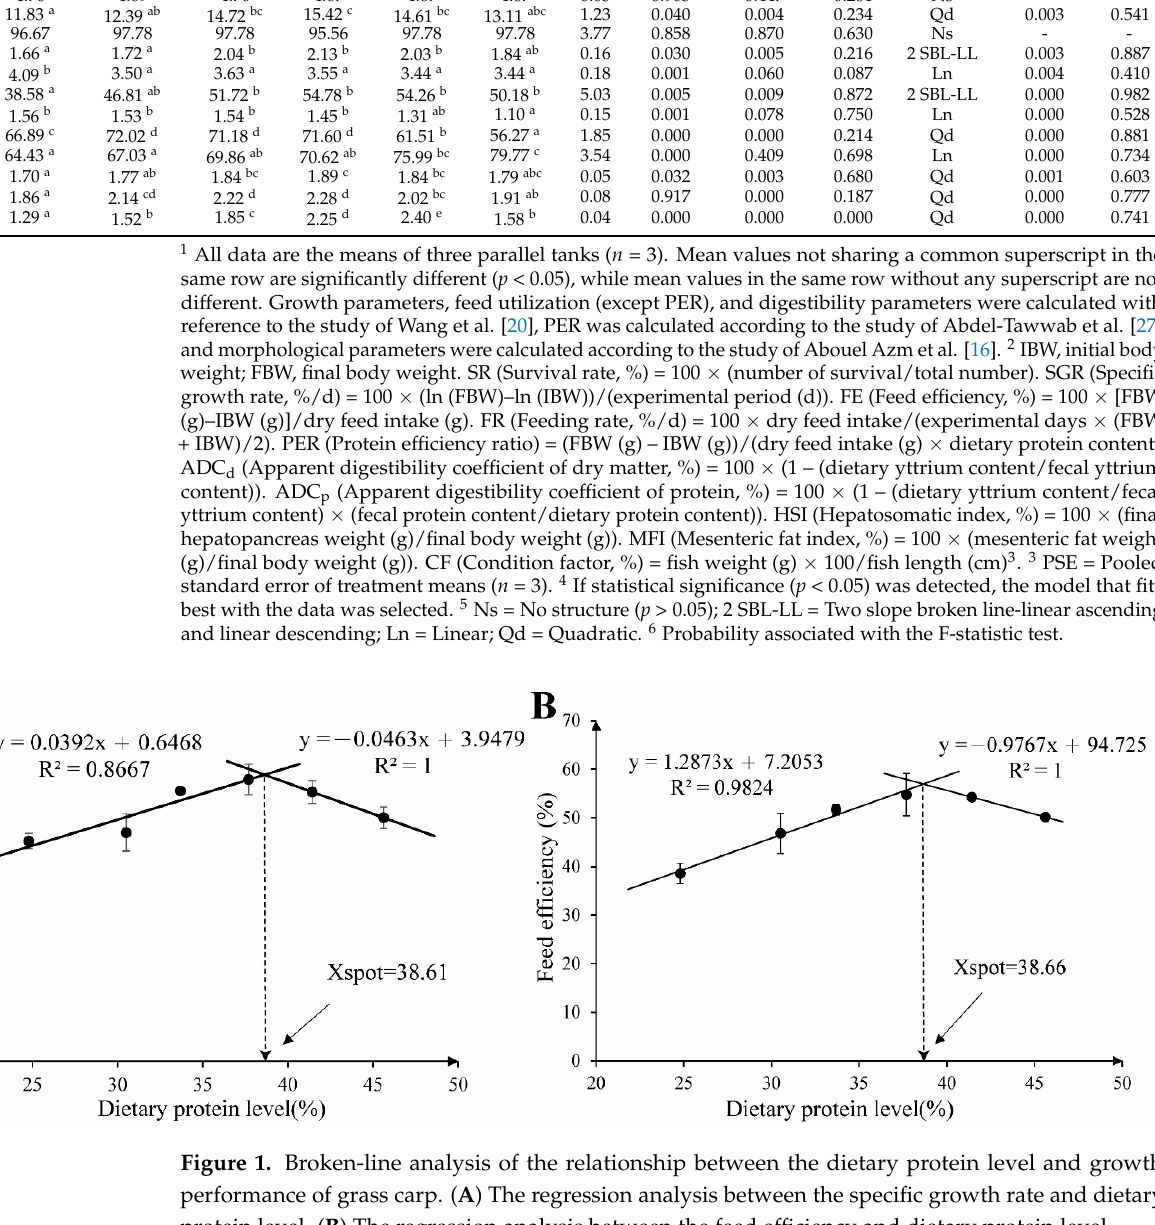
- 1 All data are the means of three parallel tanks ( n = 3). Mean values not sharing a common super- script in the same row are significantly different ( p < 0.05), while mean values in the same row without any superscript are not different. 2 PSE = Pooled standard error of treatment means ( n = 3). 3 If statistical significance ( p < 0.05) was detected, the model that fits best with the data was selected.